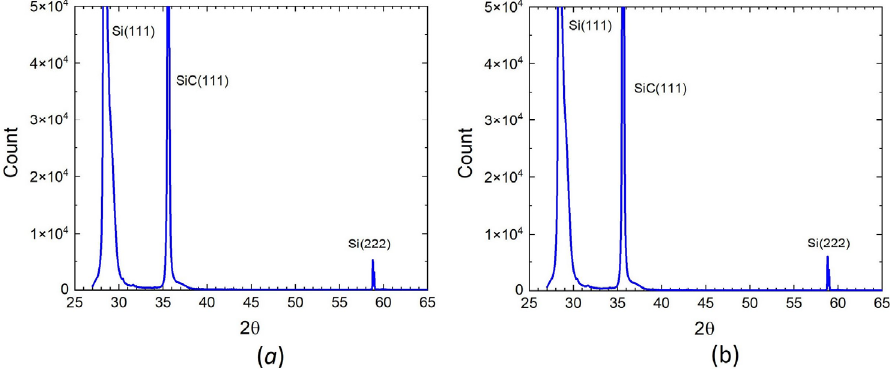
Figure 4. XRD spectra of 3C–SiC samples containing silicon vacancies grown on Si of n-type ( a ) and p-type ( b ).